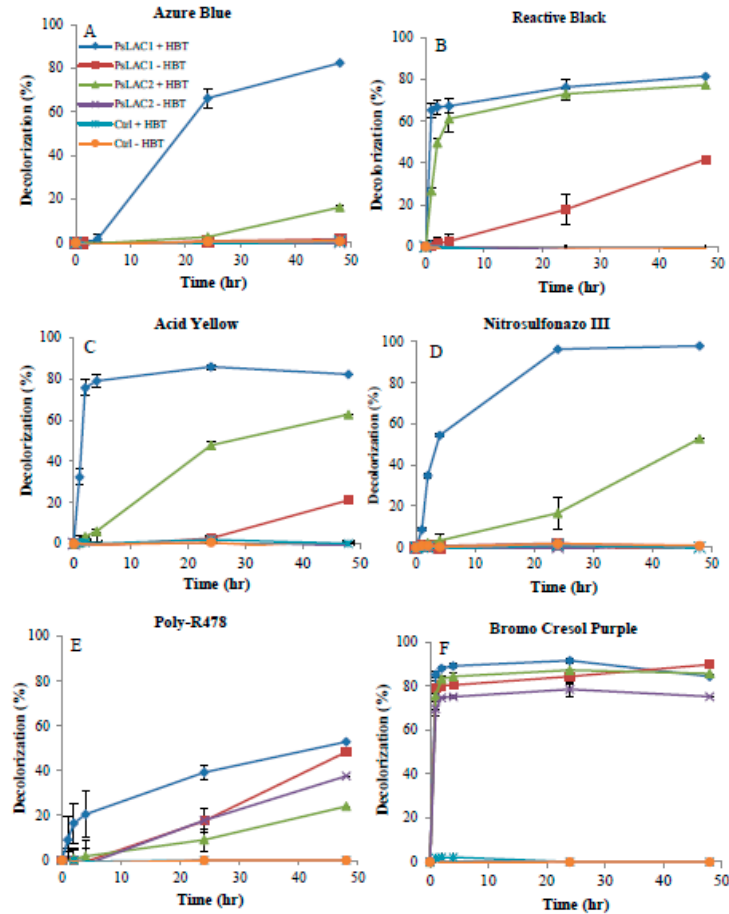
Figure 5. Decolorization of industrial dyes by Ps Lac1 and Ps Lac2. ( A – F ) The decolorization was detected by measuring the decrease of absorbance at specific wavelengths with time (1 h, 2 h, 4 h, 24 h, and 48 h). Each data point (mean +/ − standard deviation) is the result of triplicate experiments.